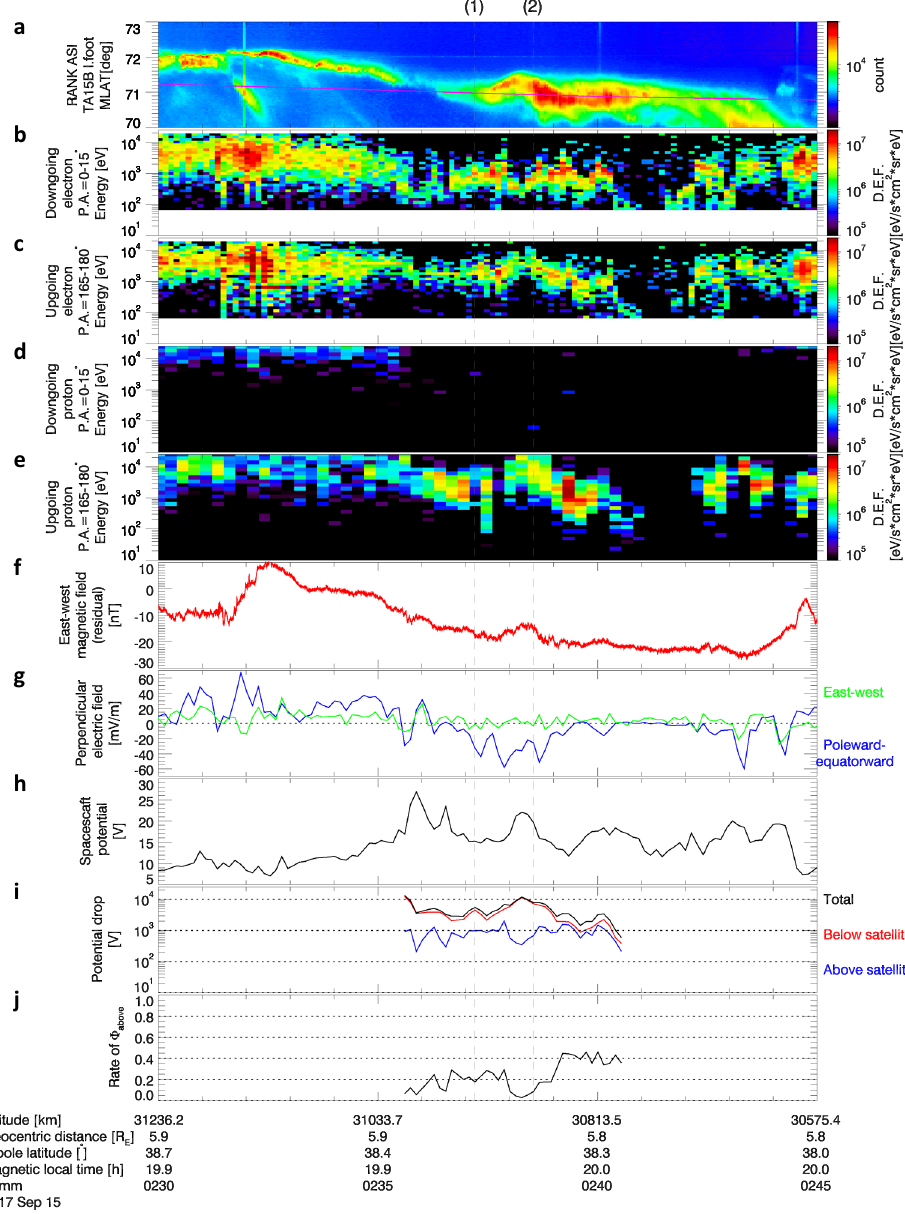
Figure 2. Time series data of observations by Arase. ( a ) Auroral intensity along the south-to-north cross- section at the blue line shown in Fig. 1. Magenta line indicates the magnetic latitude of Arase’s footprint. Differential energy fluxes of: ( b ) downgoing electrons at the pitch angle of 0°–15°; ( c ) upgoing electrons at the pitch angle of 165°–180°; ( d) downgoing protons at the pitch angle of 0°–15°; and ( e ) upgoing protons at the pitch angle of 165°–180°. The white region indicates no data in the pitch angle range. ( f ) Residual east–west magnetic field (azimuthal direction with respect to the Earth’s dipole axis) subtracted by quiet time magnetic field of Tsyganenko 89 model 36 at the Kp index of 0. ( g ) Electric field perpendicular to the magnetic field. Blue and green represent poleward and eastward electric fields, respectively. ( h ) Spacecraft potential as a proxy of electron density. ( i ) Estimated potential drops above and below the satellite. ( j ) Ratio of potential drop above the satellite to the total potential drop. The vertical dashed lines show times when phase space density distributions are shown for Fig.